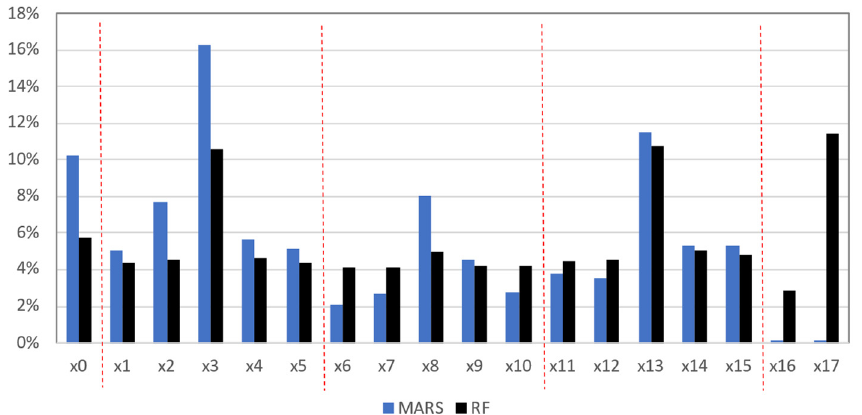
Figure 12. Features’ relevance using MARS and RF models.